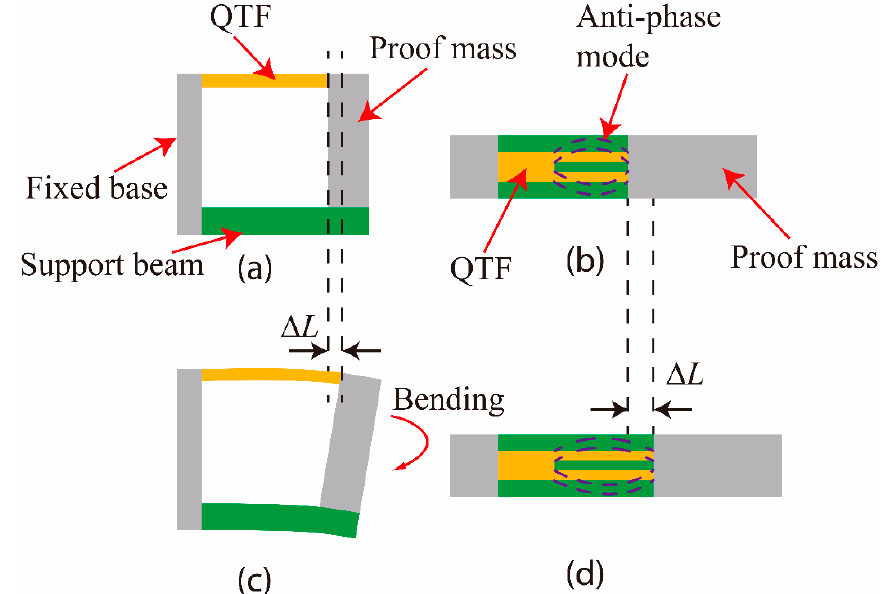
Figure 3. Illustration of the sensing mechanism of the resonant accelerometer. Without any acceleration, the accelerometer remained its original shape, and the DETF vibrated with the anti-phase mode driven via the external circuit: ( a ) side and ( b ) top views. During acceleration, the bending motion of the entire structure resulted in a strain of the DETF and changed the resonant frequency of the anti-phase vibrations: ( c ) side and ( d ) top views. The frequency shifts were exploited to determine the acceleration.